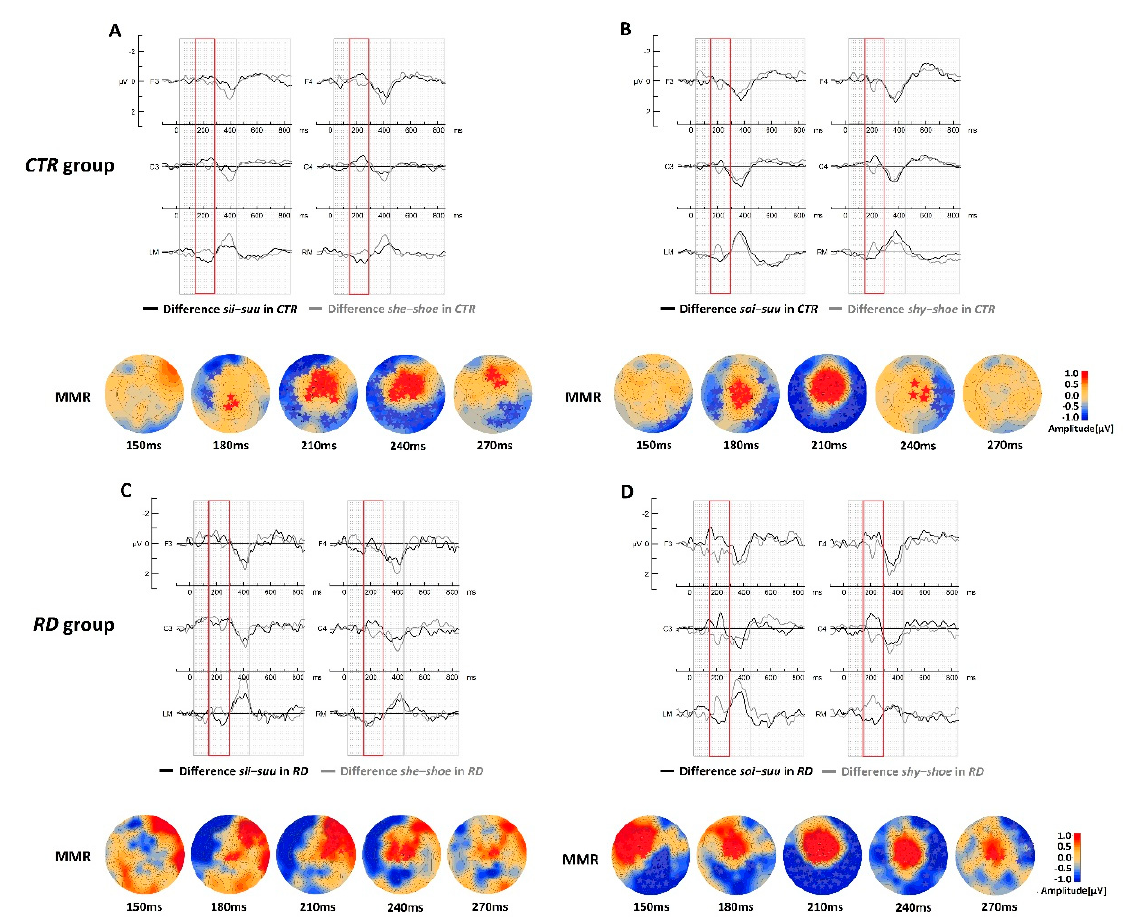
Figure 2. In the top panel, difference waveforms of CTR group ( A ) for the contrasts she - shoe (in gray) vs. sii - suu (in black) and ( B ) for the contrasts shy - shoe (in gray) vs. sai - suu (in black). The statistically significant difference topographies (English–Finnish) in the cluster-based permutation test results are presented below the corresponding waveforms. In the bottom panel, difference waveforms of the RD group ( C ) for the contrasts she - shoe (in gray) vs. sii - suu (in black) and ( D ) for the contrasts shy - shoe (in gray) vs. sai - suu (in black). The statistically significant difference topographies (English–Finnish) in the cluster-based permutation test results are presented below the corresponding waveforms. F = Frontal; C = Central; ML = left mastoid; MR = right mastoid.